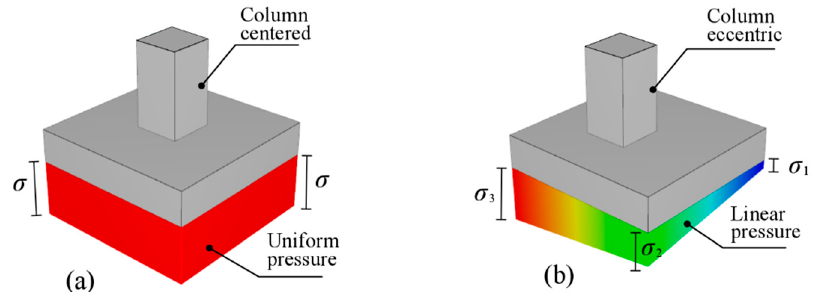
Figure 3. Pressure distribution along the contact area: ( a ) non-eccentric axial force; ( b ) eccentric axial force or/and bending moment acting on the column.